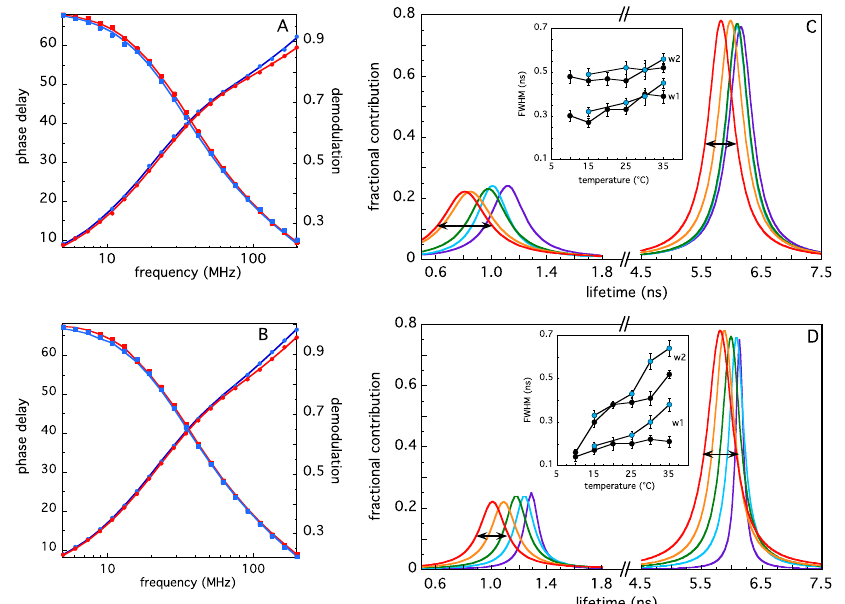
Figure 5. Phase shift (circles) and demodulation data (squares) of TRAF2-C (2 μM) at 20 °C (blue) and 37 °C (red) as a function of light excitation frequency (( A ), λ exc = 300 nm; ( B ), λ exc = 280 nm). The solid lines represent the best fit obtained using the continuous distribution of lifetimes reported in panels C (λ exc = 300 nm) and D (λ exc = 280 nm) as a function of temperature (10 °C, purple; 15 °C, cyan; 20 °C, green; 30 °C, orange; 35 °C, red). The full FWHM (black horizontal arrows) at each temperature are reported in the insets of panels ( C , D ), at two different concentrations, namely 2 μM (black sym- bols) and 0.2 μM (cyan symbols).